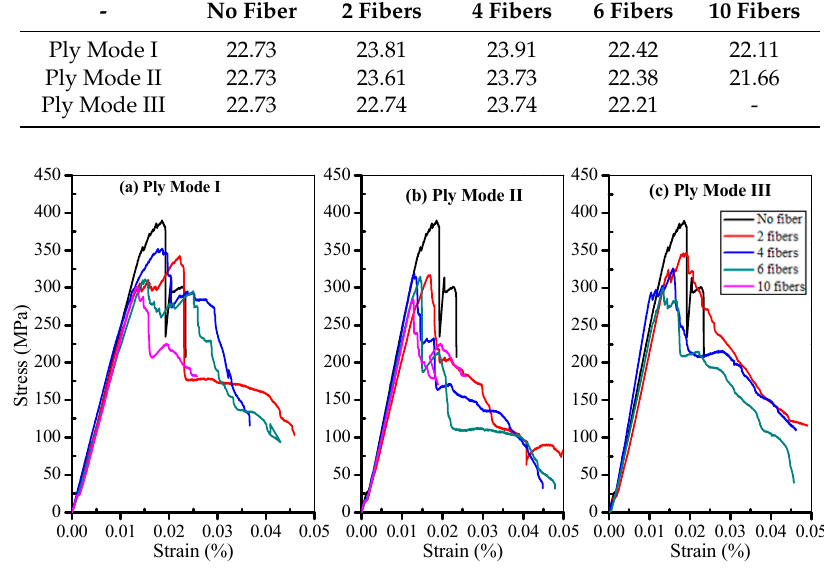
Table 1. Flexural modulus of SMA composite laminates with various ply modes (GPa).